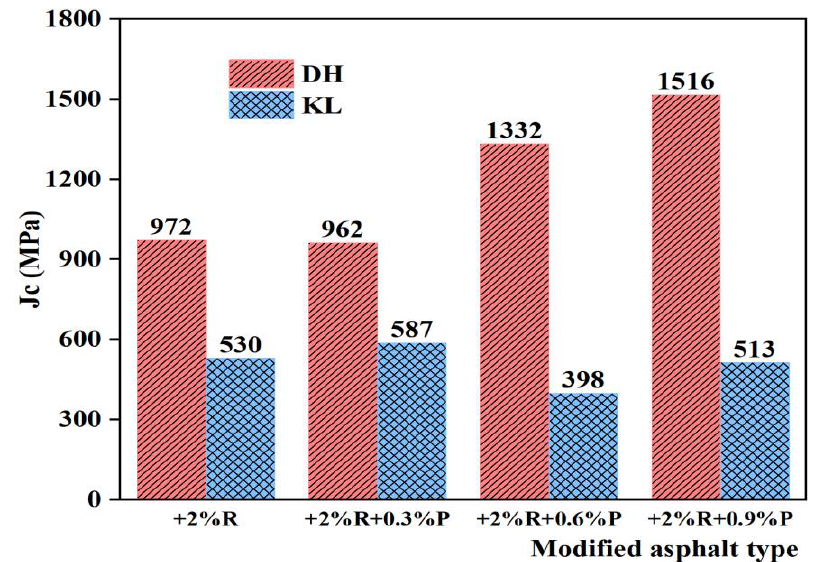
Figure 15. The Jc value of composite modified asphalt with different PPA/SBR dosages.